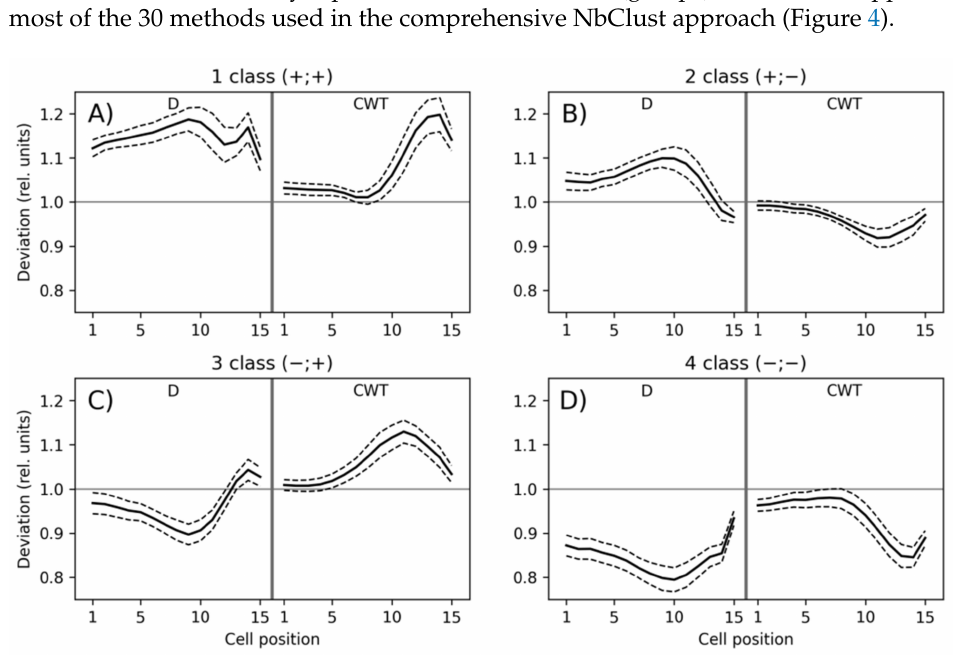
Figure 4. 30-dimensional average objects (D and CWT tracheidograms, bold solid curves) for the 1st ( A ), 2nd ( B ), 3rd ( C ) and 4th ( D ) clusters (classes). Plus(+)/Minus( − ) indicates the above/below value relative to the cluster (class) average. The dashed curves are ± standard